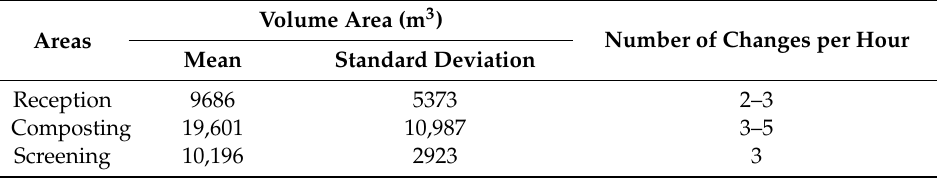
Table 2. Descriptive analysis of air changes in the three main operative